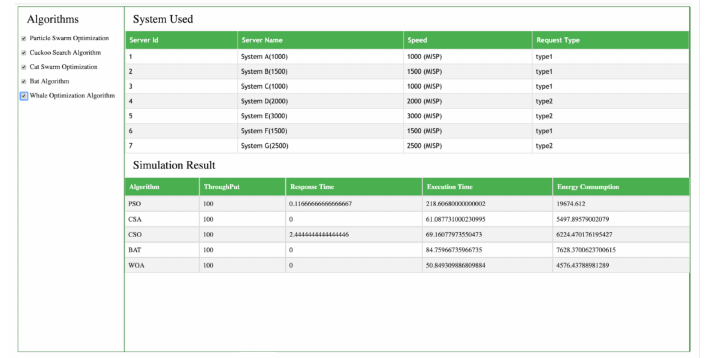
Figure 8. Algorithm results with seven servers.